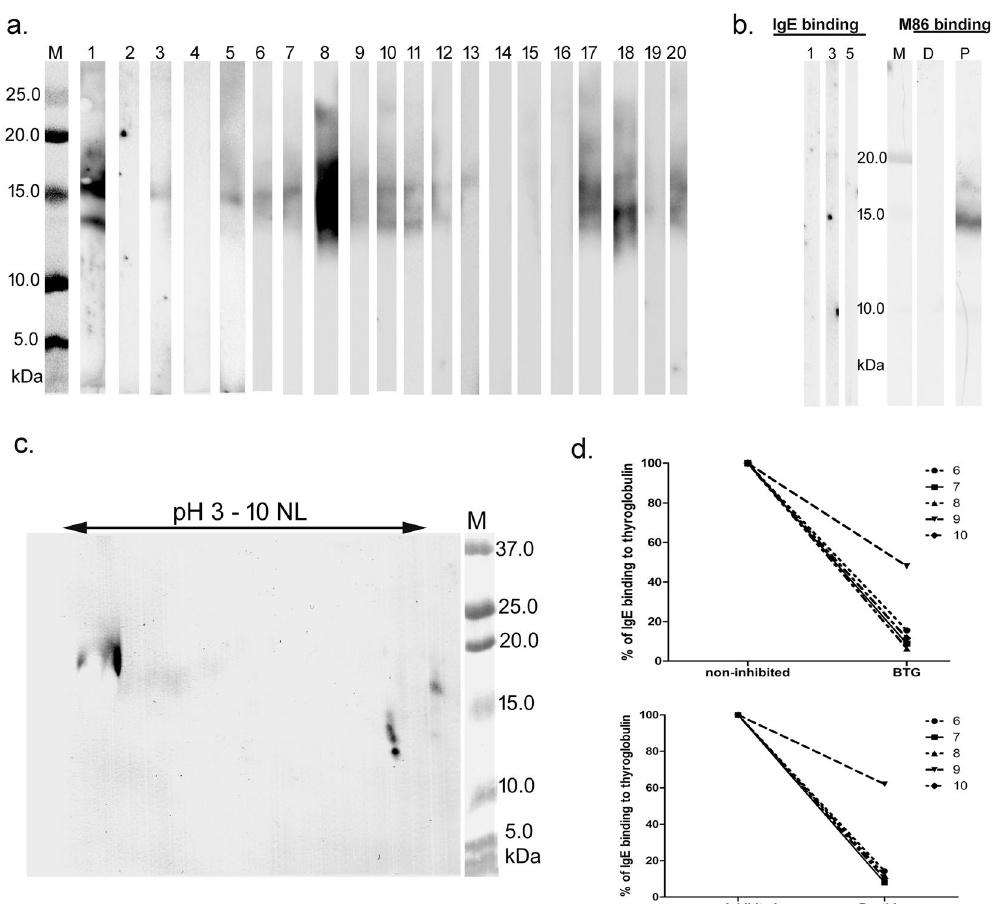
Figure 3. Allergenic properties of bovine thyroglobulin pepsinolysis products. ( a ) Individual patients’ IgE-binding properties on immunoblot with bovine thyroglobulin peptides obtained after 60 min of gastric digestion with 0.2 U per µ g of pepsin. ( b ) Left side of the panel: IgE binding of three individual patients on deglycosylated peptides; right side of the panel: anti- α -Gal binding on α -Gal peptides-P, and deglycosylated peptides -D; M-Molecular weight markers. ( c ) 2D immunoblot of α -Gal peptides developed with the serum pool from 20 red meat-allergic patients. M-Molecular weight markers; ( d ) Inhibition of IgE binding to bovine thyroglobulin using preincubation with bovine thyroglobulin or thyroglobulin peptides obtained after 60 min of gastric